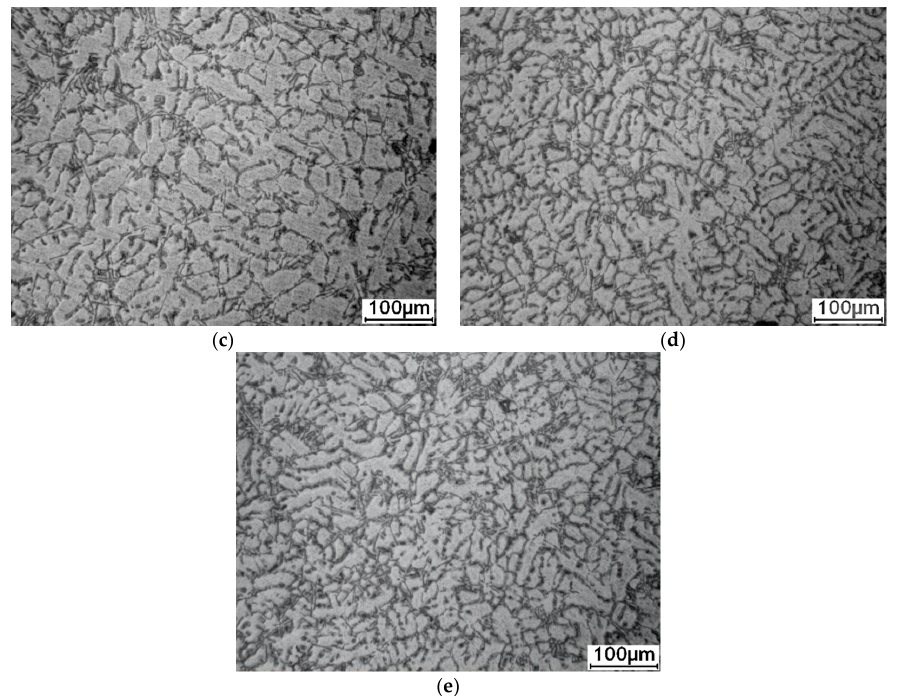
Figure 8. The α -Al in Al-8Si alloy modified with different amount of Al-5Ti-0.62C-0.2Ce master alloy: ( a ) unmodified; ( b ) 0.8%; ( c ) 1.0%; ( d ) 1.5%; and ( e ) 2.0%.